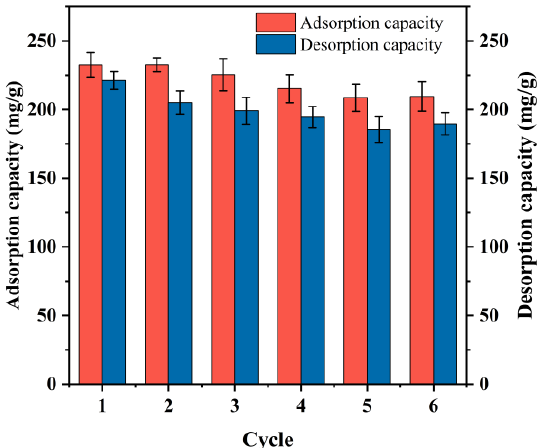
Figure 13. Repeated adsorption – desorption performance of PDA/PEI-TPU NFMs on CR